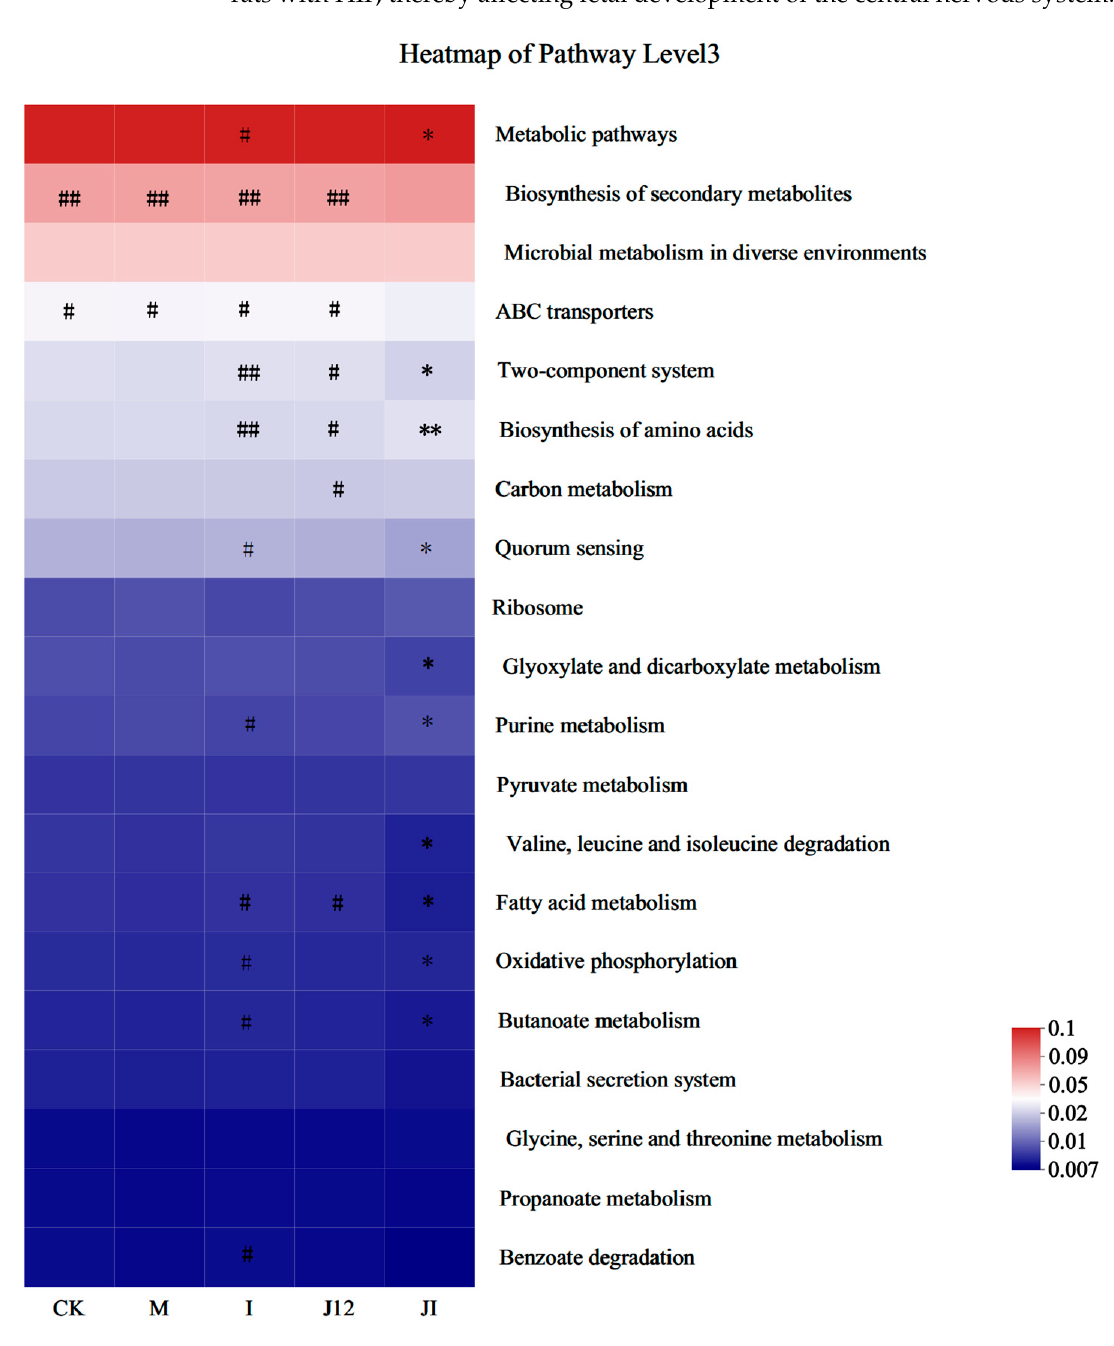
Figure 9. Predicted metabolic profile of the placental microbiome after J-12 supplementation. The 16S rRNA data were further analyzed as indicated by the PICRUSt. Statistical analyses were performed by using a one-way ANOVA with Tukey’s multiple comparison test. Data are presented as the means ± SD; * p < 0.05, ** p < 0.01, compared with the CK group; # p < 0.01 and ## p < 0.01, compared with the J + I group.